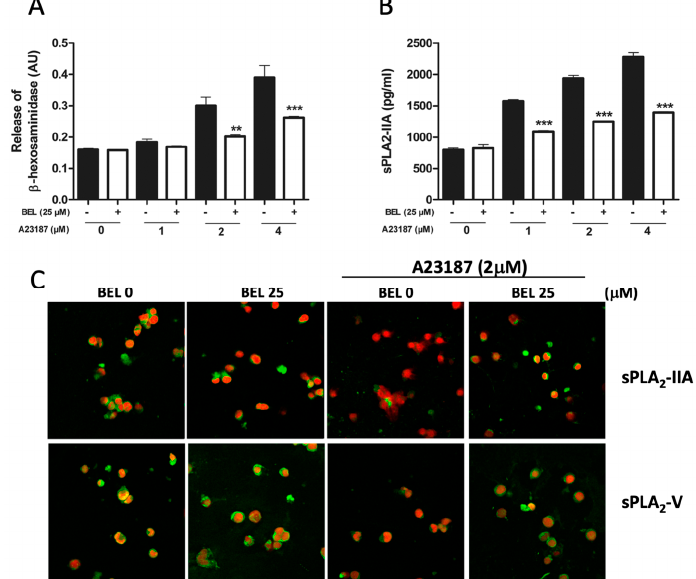
Figure 6. Effect of iPLA 2 inhibition on A23187-induced degranulation and release of sPLA 2 -IIA and sPLA 2 -V in HMC-1. ( A ) Effect of the specific iPLA 2 inhibitor bromoenol lactone (BEL) on the release of β -hexosaminidase. ( B ) Effect of the specific iPLA 2 inhibitor BEL on the release of sPLA 2 -IIA measured by ELISA. ( C ) Immunocytochemical analysis, visualizing the effect on the release of sPLA 2 -IIA and sPLA 2 -V. Green staining is for sPLA 2 -IIA or sPLA 2 -V and red staining is for visualization of cell nuclei (magnification × 600). Note that the expression of sPLA α , as described in Figure 2A and 2 -V had to be upregulated by TNF B, to be illustrated. ** p < 0.01, *** p < 0.001 vs. controls. Data from three independent